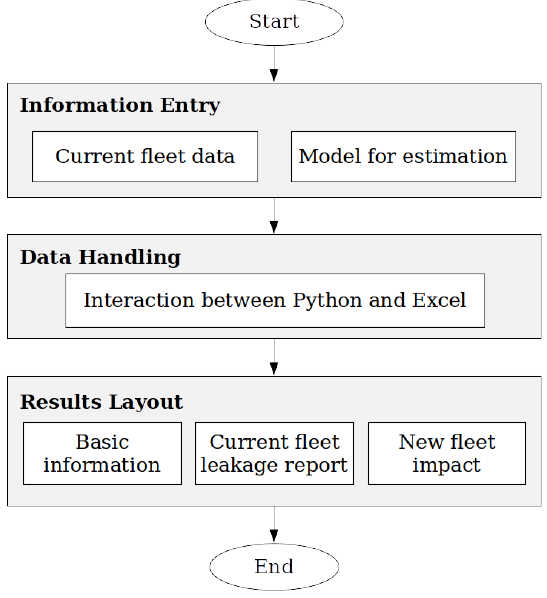
Figure 1. Flowchart of the